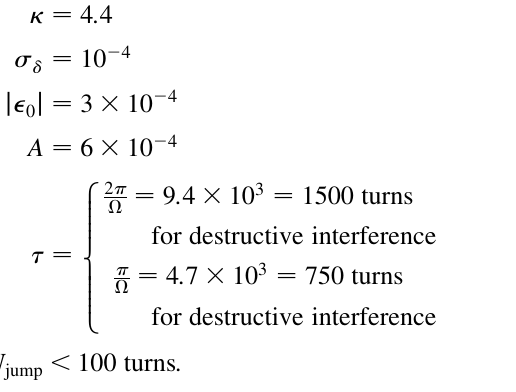
j (cid:1) j A j 0